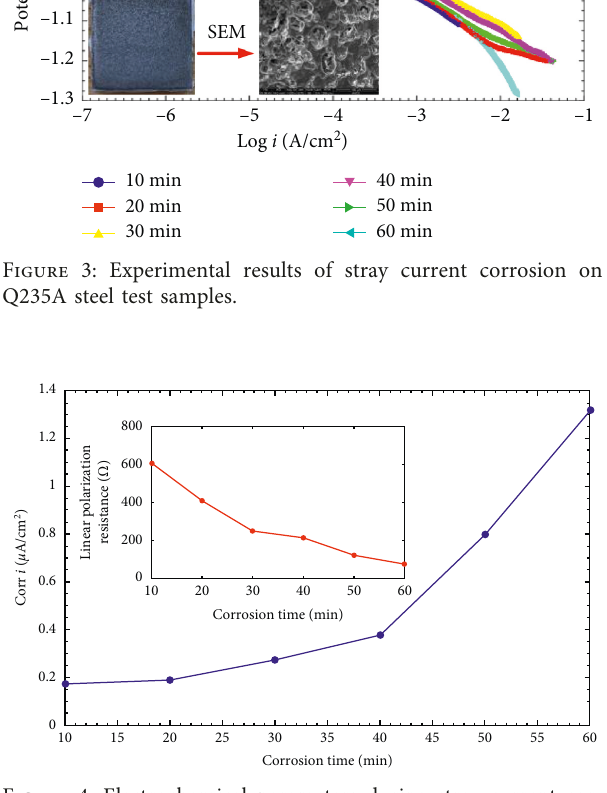
Figure 4: Electrochemical parameters during stray current cor- rosion on Q235A steel test samples.